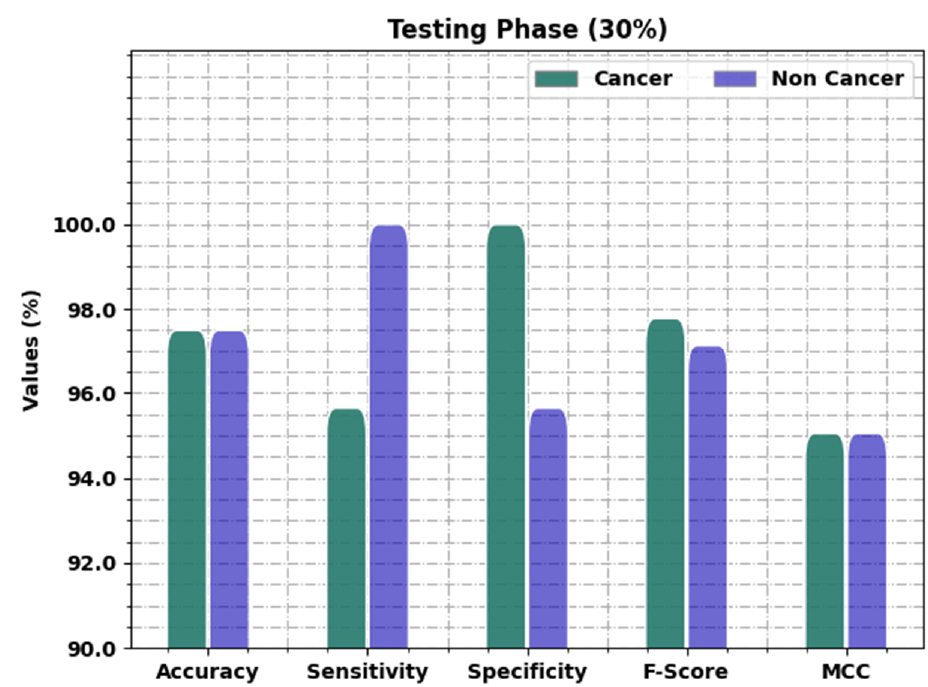
result inferred that the OIDCNN-OPMDD approach had achieved maximal values of TRA